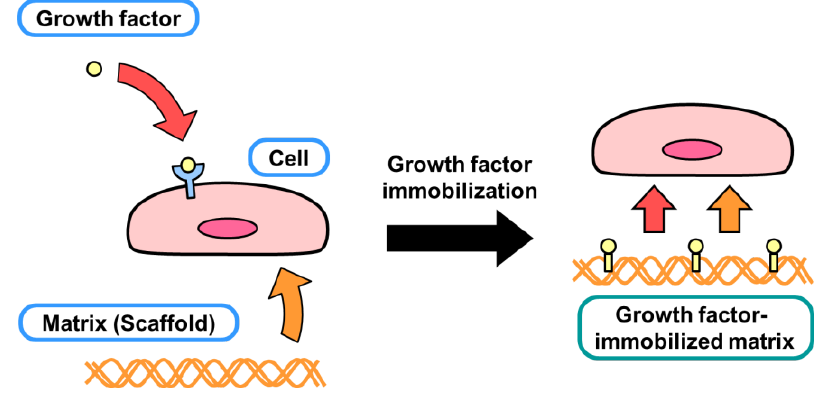
Figure 2. Three main factors in tissue engineering: cells, growth factors and matrices (scaffolds). The conjugation of growth factors and matrices provides a new approach for generating biofunctional substrates for regenerative medicine.